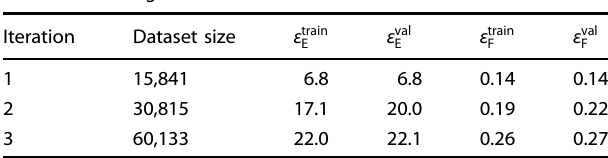
Fig. 2 The evolution of the distribution of error in energy prediction. The RMSE in prediction of per atom energy for potentials trained at fi rst, second, and third iteration of the self-consistent cycle is given in a – c , respectively. The blue lines are the RMSE on a given batch of 128 con fi gurations during training. The networks are evaluated during training on all the validation set of sizes ≈ 3000, ≈ 5200 and, ≈ 12000 con fi gurations for fi rst, second, and third iterations, respectively (red dots with lines as guide to eye). The fi nal training and validation RMSE are reported in Table 1. d Error distribution for the validation dataset at third iteration. The black dashed line is a normalized Gaussian fi t, resulting in an RMSE of 11.3 meV, clearly failing to fi t the fat-tailed distribution. The error distribution of energy and force prediction for all iterations is given in Supplementary Fig. 3. Table 1. Training and validation